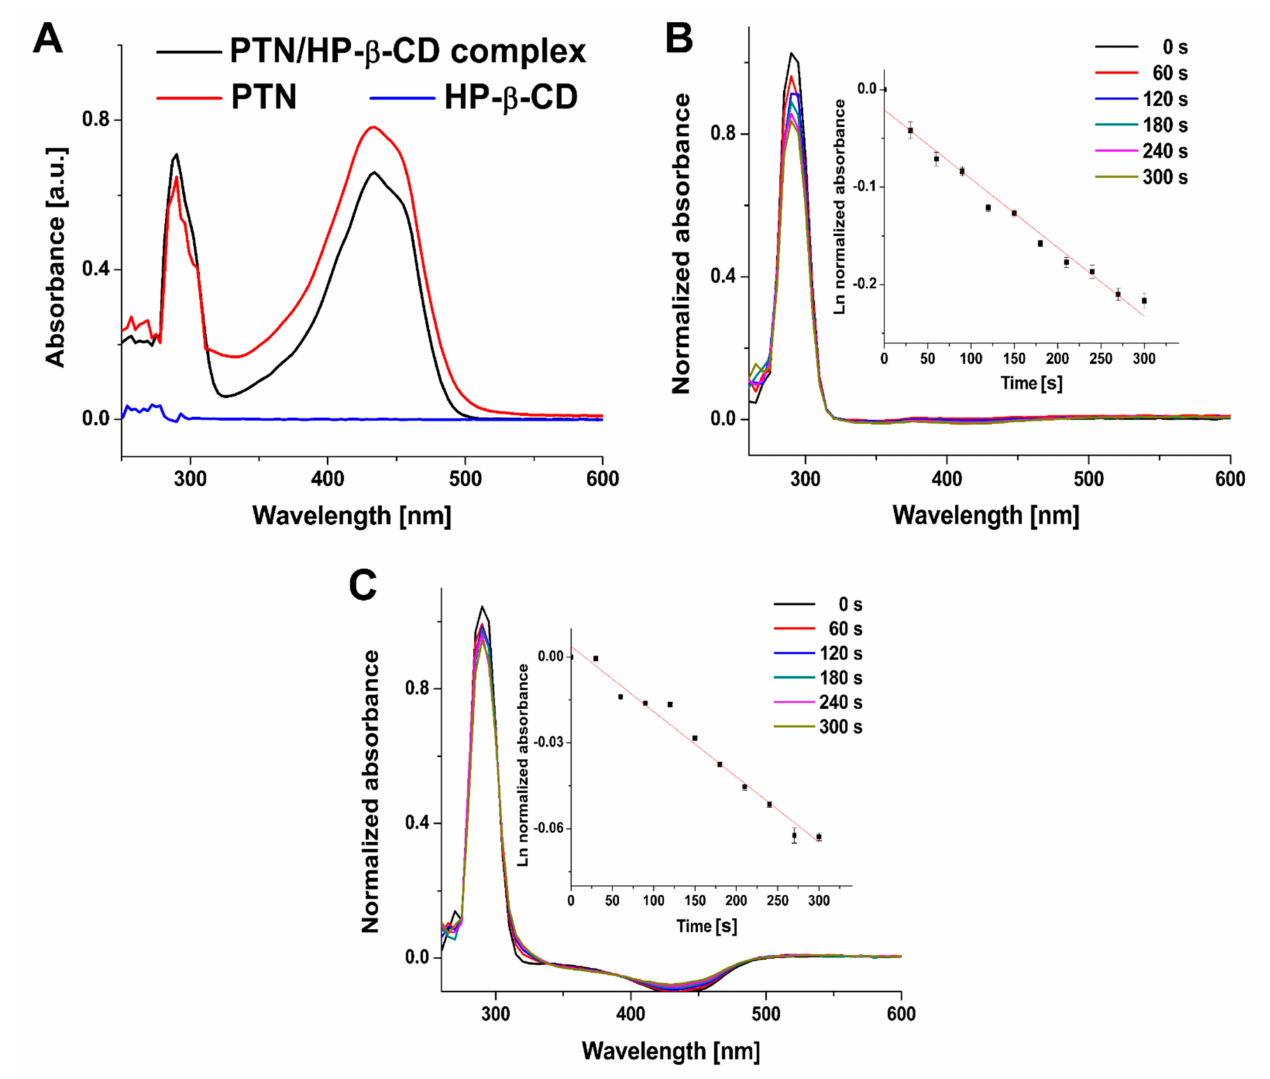
Figure 8. ( A ) UV/Vis spectra of PTN in ethanol (80 µ g/mL), HP- β -CD in water (0.5 mg/mL) and PTN/HP- β -CD inclusion complexes in water (80 µ g/mL). ( B , C ) Absorption spectra of uric acid upon irradiation for different times in the presence of ( B ) free PTN and ( C ) PTN/HP- β -CD complexes. The insets represent the plot of Ln normalized absorbance of uric acid at λ = 296 nm versus irradiation time in s ( λ irr = 457 nm, irradiance = 220.2 W/m 2 ). All measurements were performed in triplicate, and the values were expressed as means ± SDs ( n =